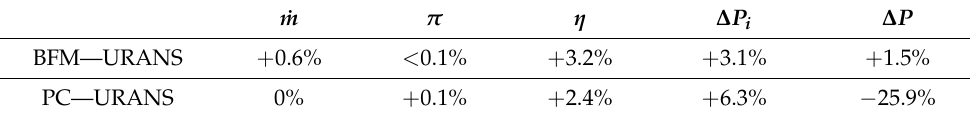
Table 3. Relative discrepancy between URANS and lower-fidelity approaches.